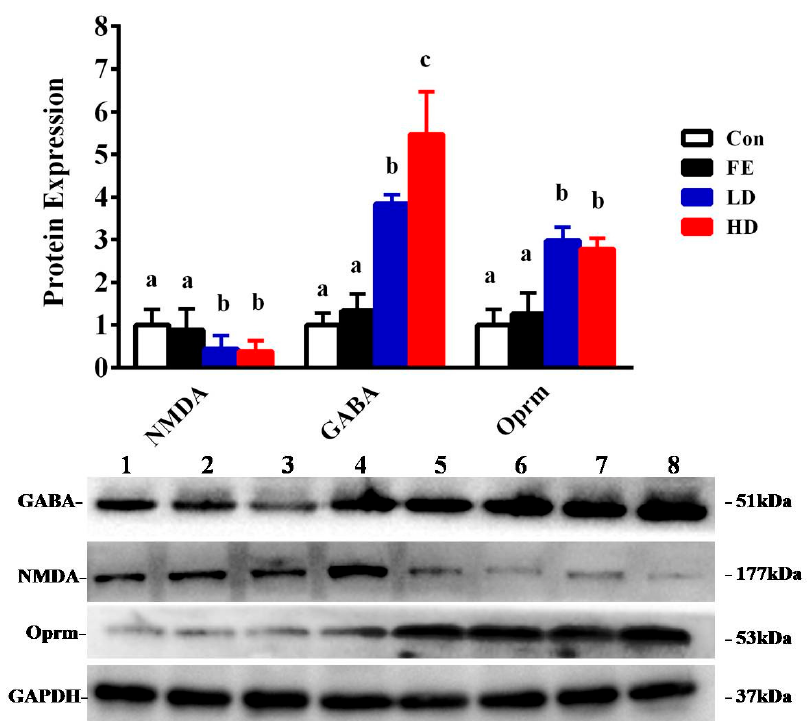
Figure 2. The determination of protein expression in the parietal lobe of Sprague Dawley (SD) rats injected with different drugs. The control (Con) group is indicated by a blank bar, the fat emulsion (FE) group is indicated by a black bar, the low-concentration (LD) group is indicated by a blue bar, and the high-concentration (HD) group is indicated by a red bar. Compared to the protein expression of the Con group and FE group, the LD group and HD group show significant changes. Superscripts with different letters indicate significant differences ( p < 0.05). The left-to-right bands of each protein represent the corresponding protein expression levels in the parietal cortex samples of SD rats injected with different drugs and concentrations.